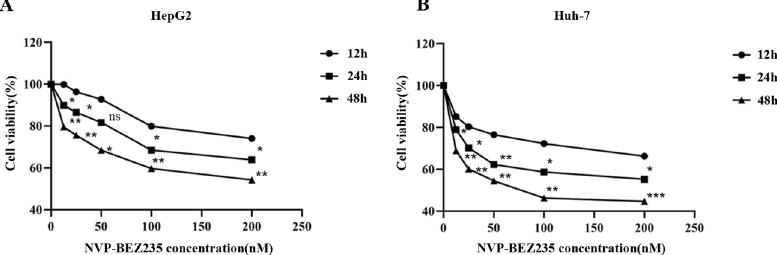
Fig. 2 NVP-BEZ235 inhibits HCC cell proliferation in a dose- and time-dependent manner. A The proliferation rate of HepG2 cells treated with NVP-BEZ235. B The proliferation rate of Huh-7 cells treated with NVP-BEZ235. Compared to the 12 h treatment group. ns ≥ 0.05, * P < 0.05, ** P < 0.01, * P <